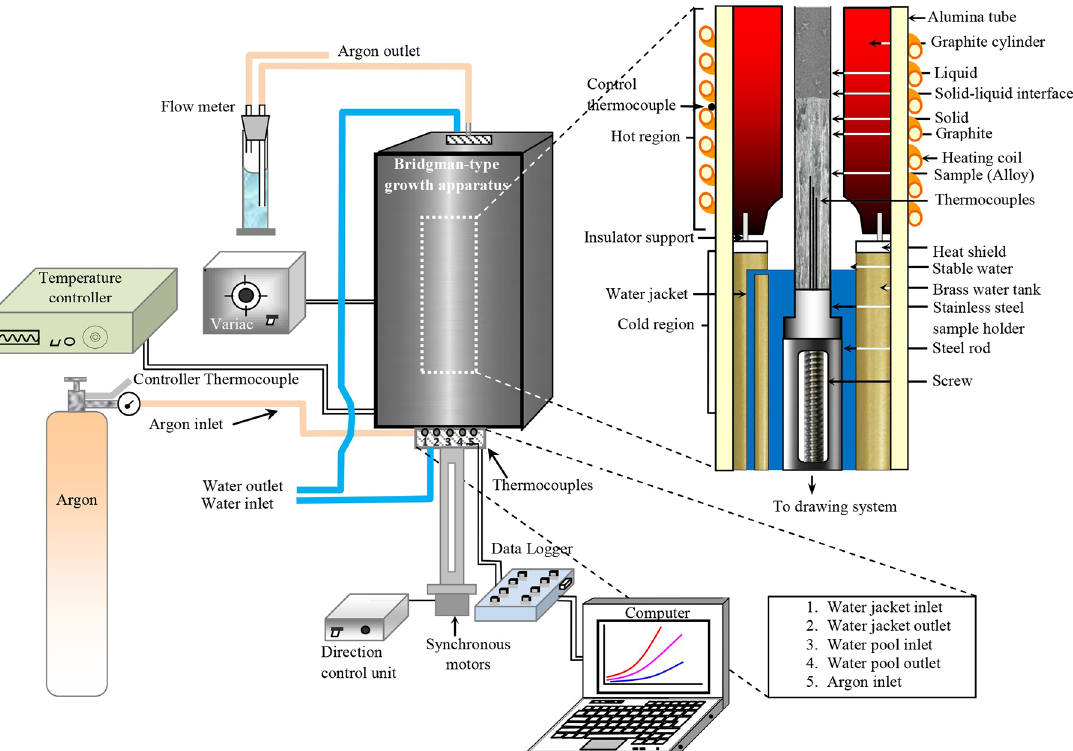
Figure 2. The details of the Bridgman-type growth